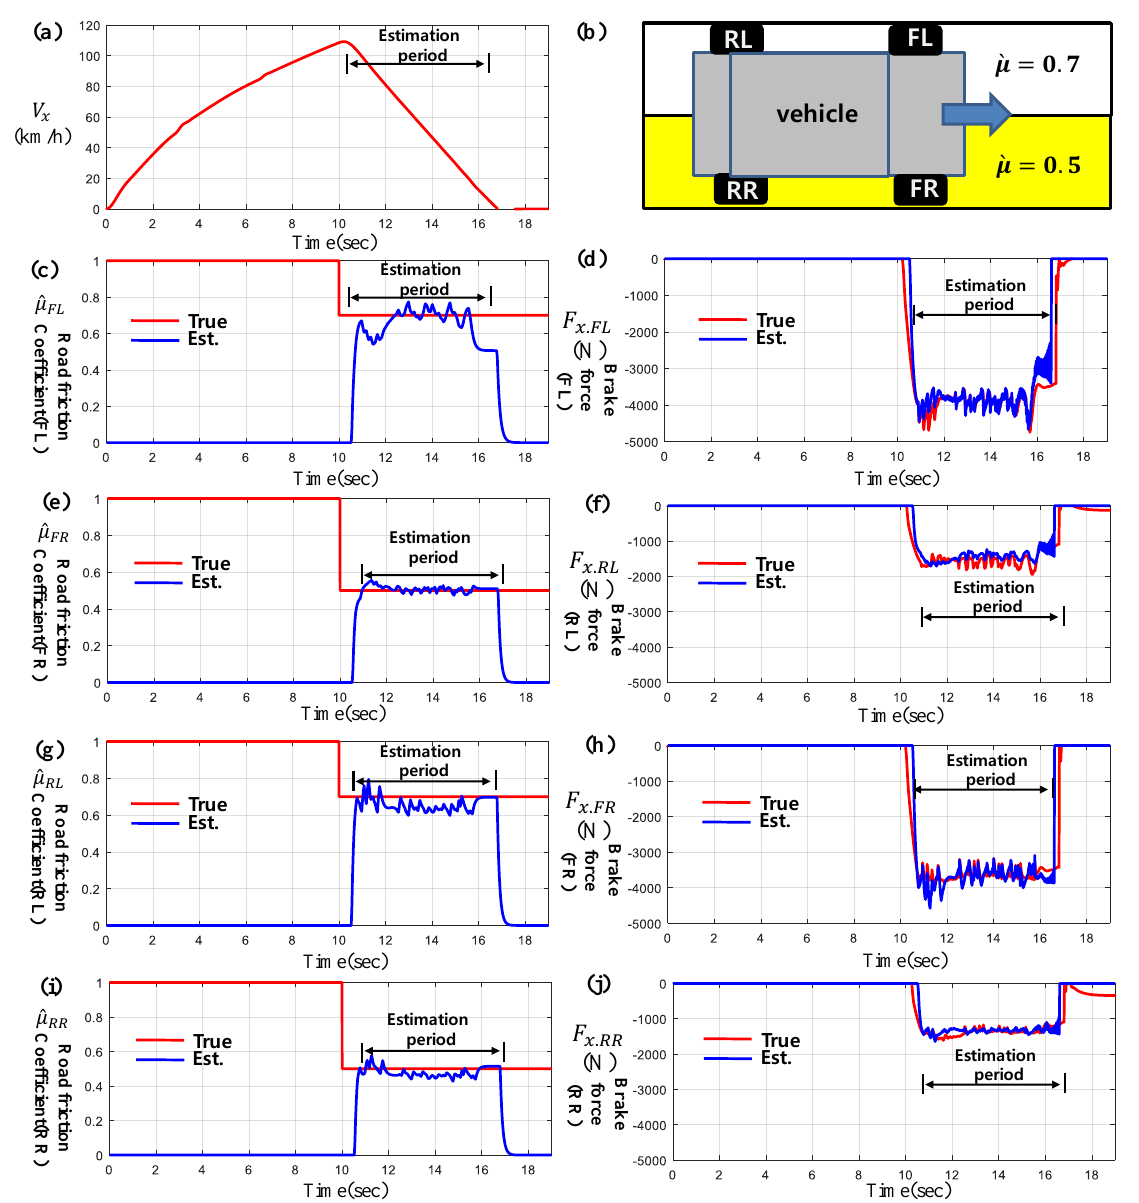
Figure 15. Estimation results of road friction coefficients and brake forces for split-friction road. ( a ) Longitudinal vehicle speed, ( b ) split-friction road condition ( 𝜇 = 0.7 for left and 𝜇 = 0.5 for right), ( c ) friction estimation of FL wheel, ( d ) brake force of FL wheel, ( e ) friction estimation of FR wheel, ( f ) brake force of FR wheel, ( g ) friction estimation of RL wheel, ( h ) brake force of RL wheel, ( i ) friction estimation of RR wheel, and ( j ) brake force of RR wheel.